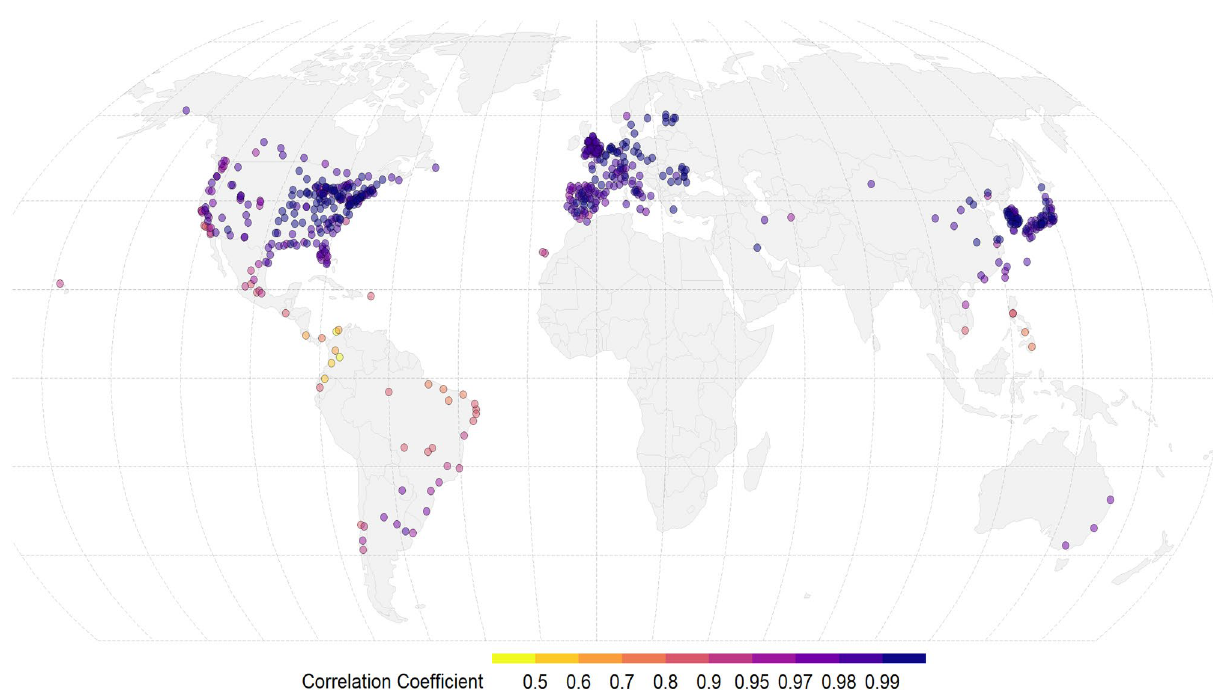
Figure 2. Correlation between MCC weather station and ERA5-Land daily mean temperature (°C) across the 612 locations used in the